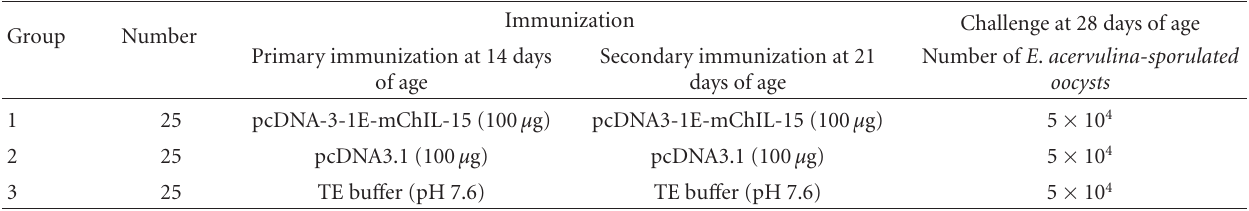
Table 1: Experimental groups used in immunization and challenge experiments.